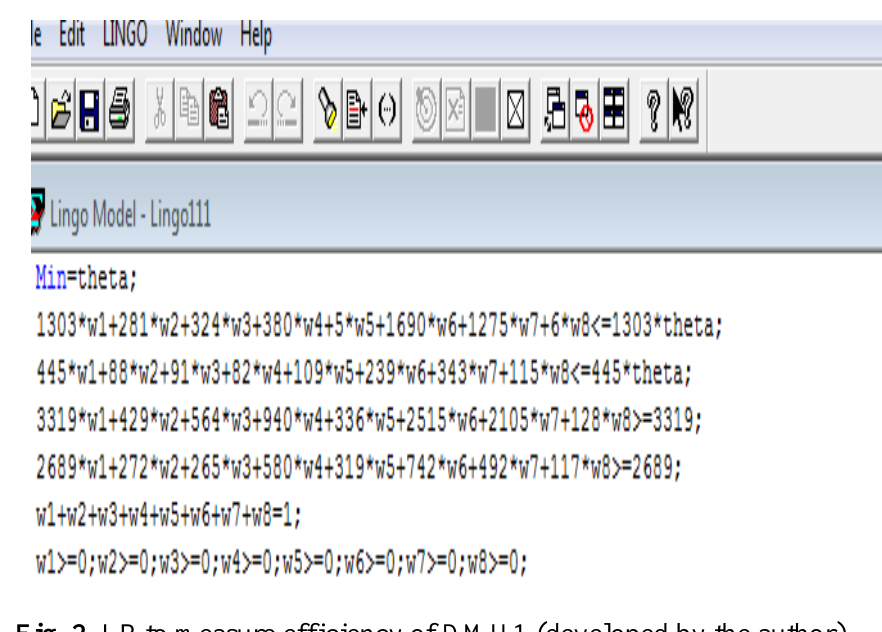
Fig. 2. LP to measure efficiency of DMU1 (developed by the author).